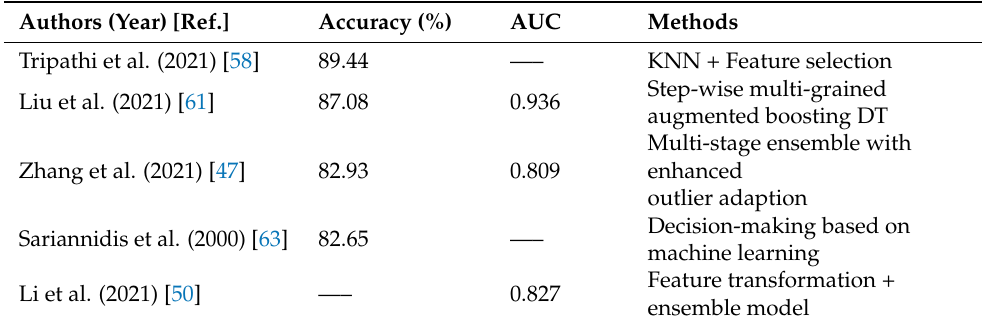
Table 6. Accuracy and area under the receiver operating characteristic curve (AUC) values of hybrid and ensemble classifiers for the Taiwanese